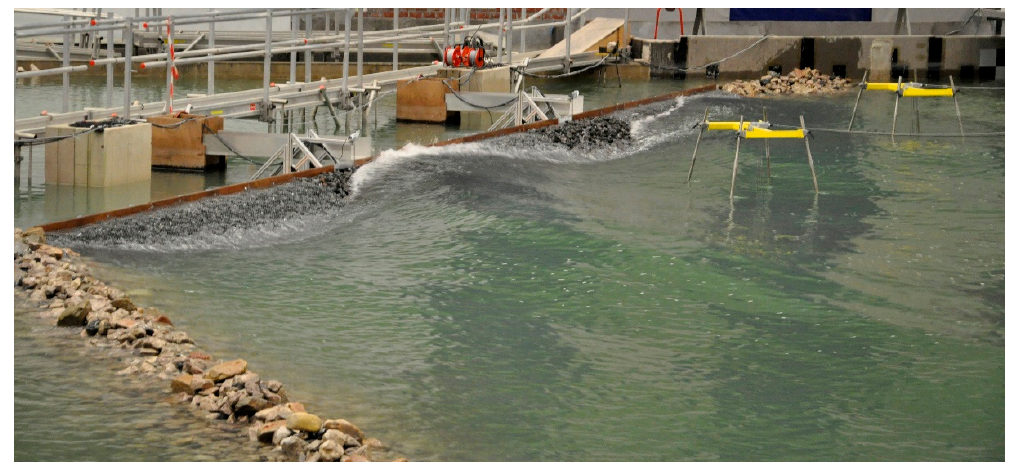
Figure 4. Experimental set-up during a test with oblique waves.